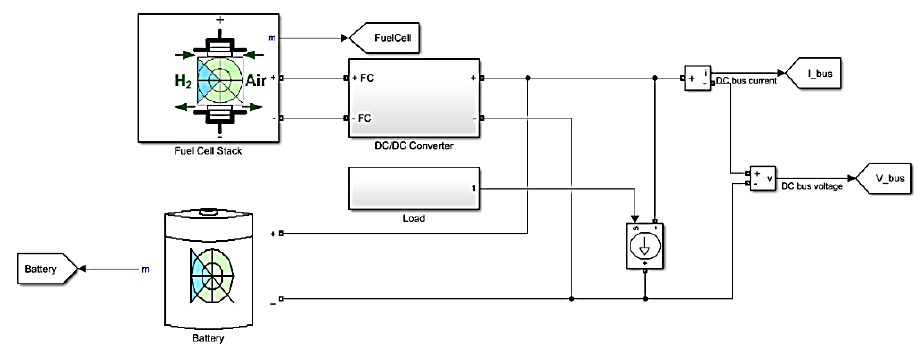
Figure 9. Circuit schematic for overall system simulation.